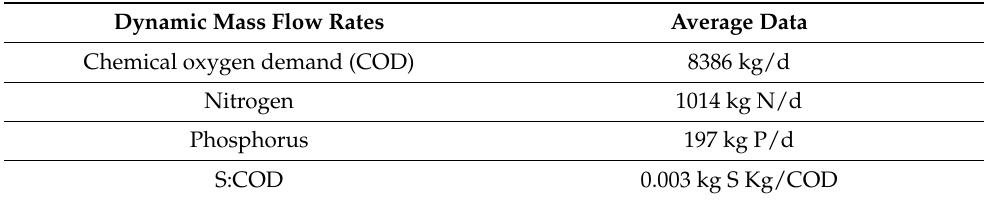
Table 1. Average data of dynamic mass flow rates.